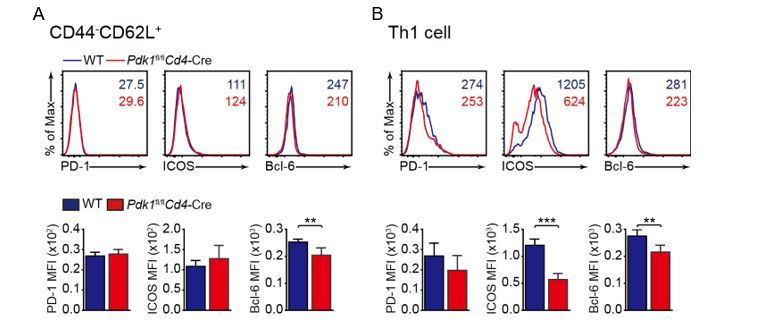
Analysis of PD-1, ICOS, and Bcl-6 expression in naive (A), and Th1 (B) cells.